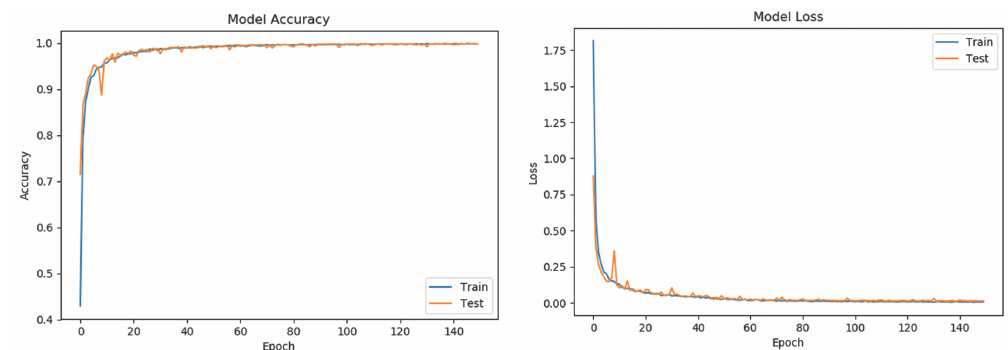
Figure 9. Performance of trained RNN 5 with optimized DR value and number of neurons, evaluated with mean accuracy rate ( left ) and loss function ( right ).